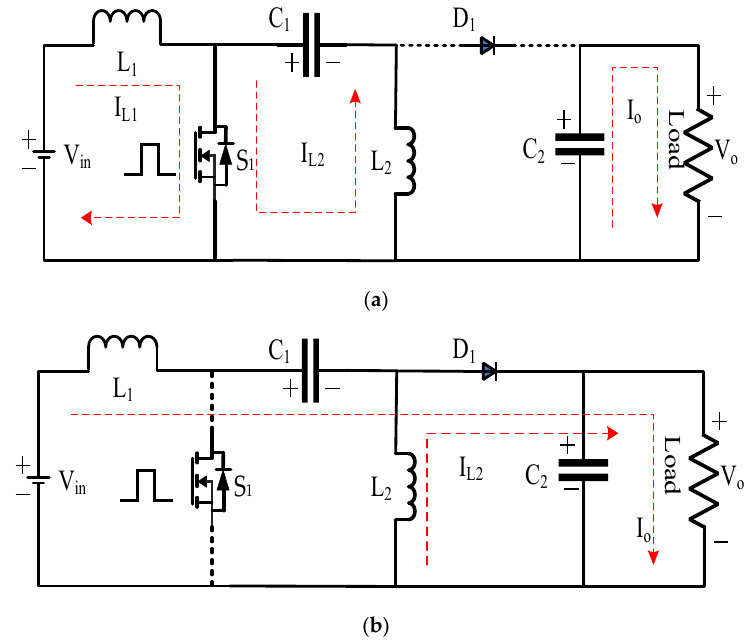
Figure 2. SEPIC Converter’s operate mode: ( a ) power MOSFET S 1 during the ON state, ( b ) power MOSFET S 1 during the OFF state.